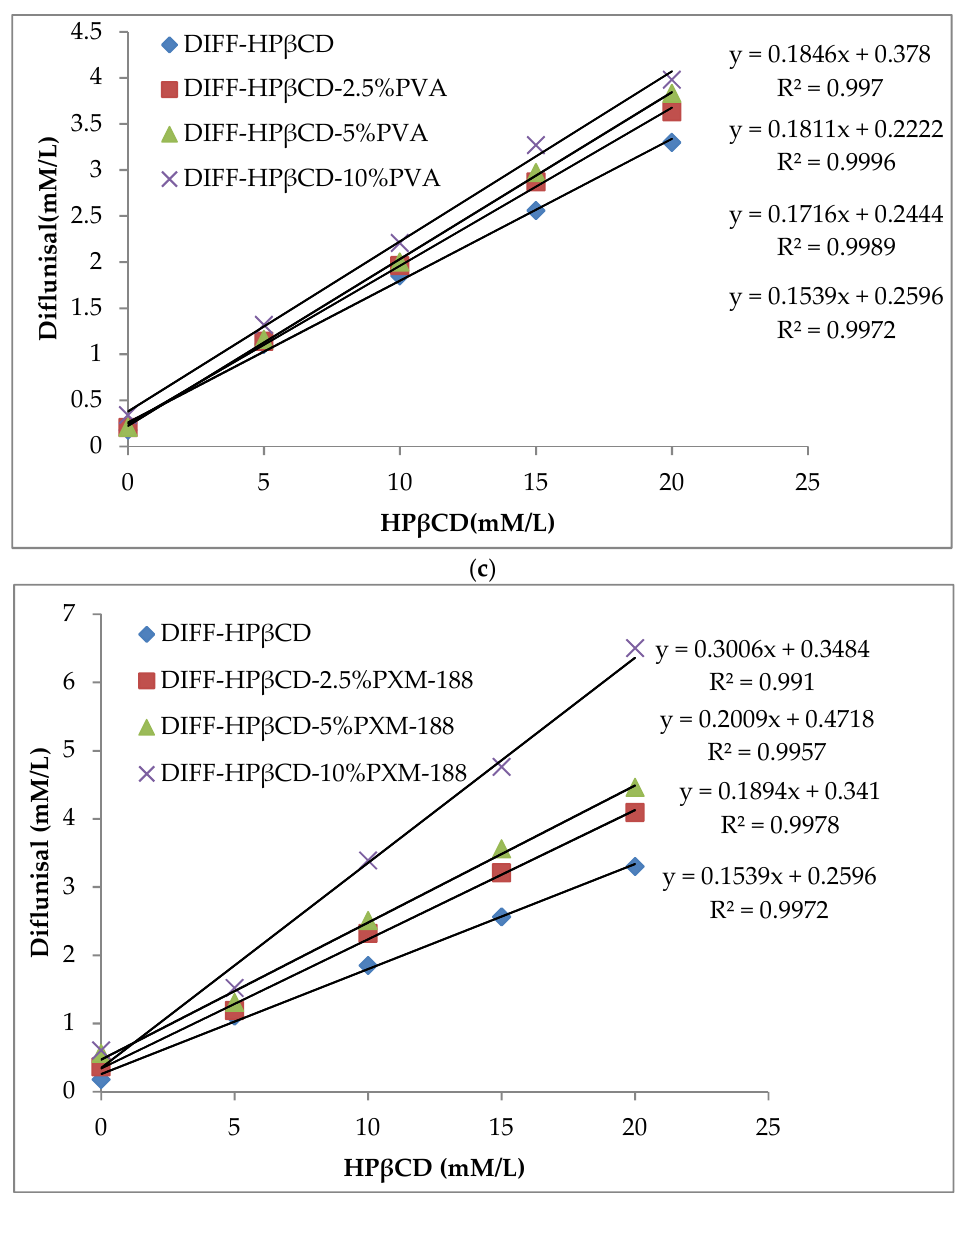
Figure 1. Phase solubility diagram of DIF in aqueous solution of βCD with/without PVA (a); with/without PXM-188 (b); Phase solubility diagram of DIF in aqueous solution of HPβCD with/without PVA (c) ; with/without PXM-188 (d) . Mean ± SD, N=3. Table 1. Stability constant and complexation efficiency results of binary and ternary inclusion complexes.